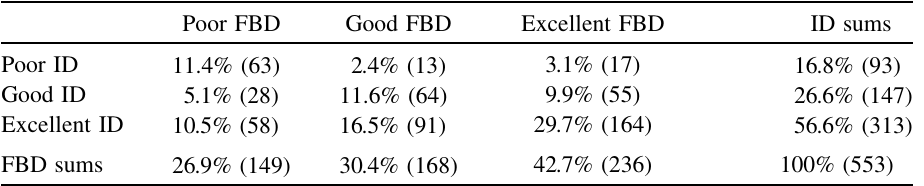
TABLE V. Crosstab for the ID þ FBD pairs in the heavy ID group. The number of pairs is reported in parenthesis.